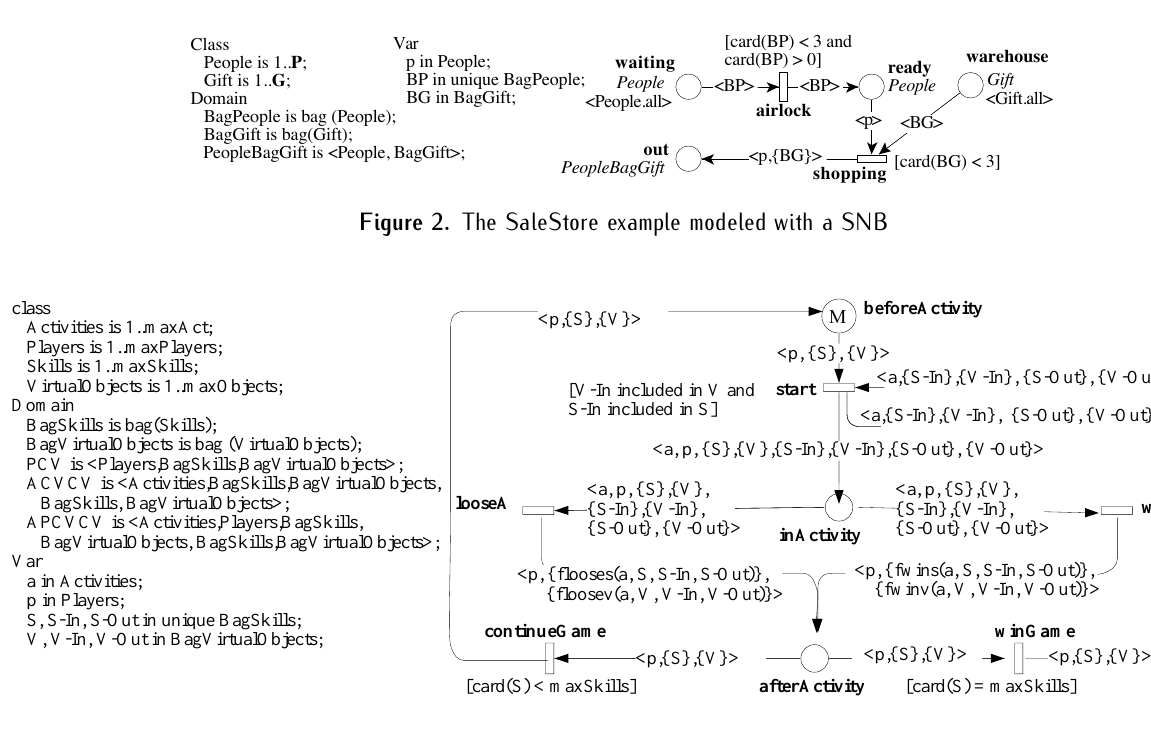
Figure 3. Modeling a game activity in SNB.